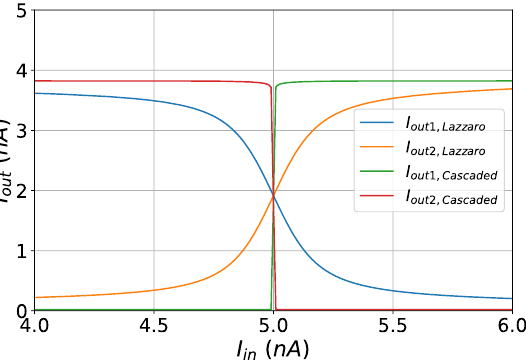
Figure 14. A comparison between the simple and the implemented WTA circuits.